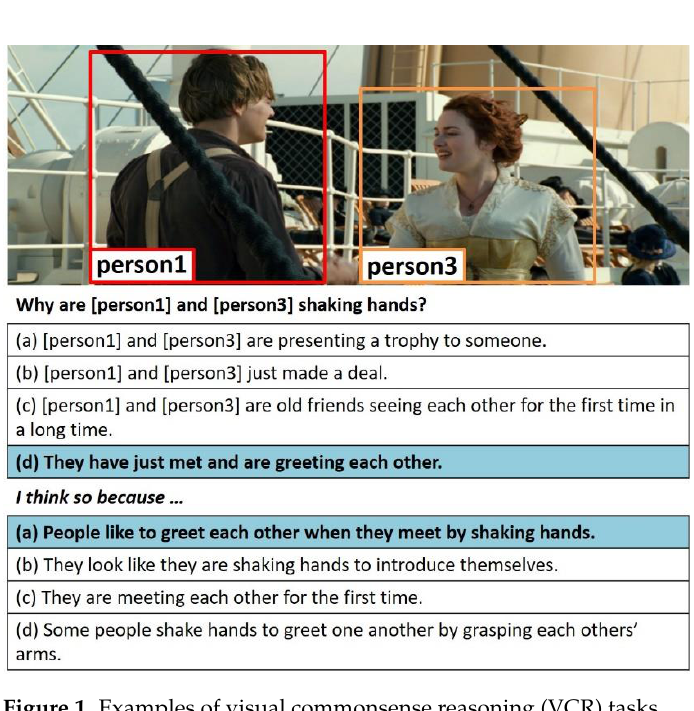
Figure 1. Examples of visual commonsense reasoning (VCR) tasks.